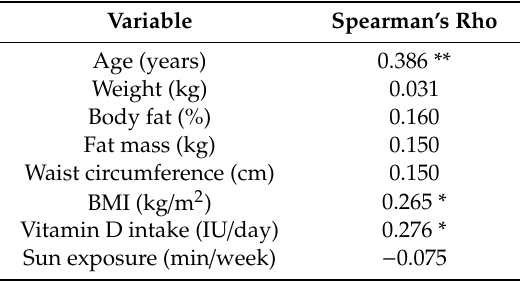
Table 5. Association of serum 25(OH)D levels with ventricular function, lifestyle, and anthropometric parameters in patients with heart failure for the 12-month follow-up.